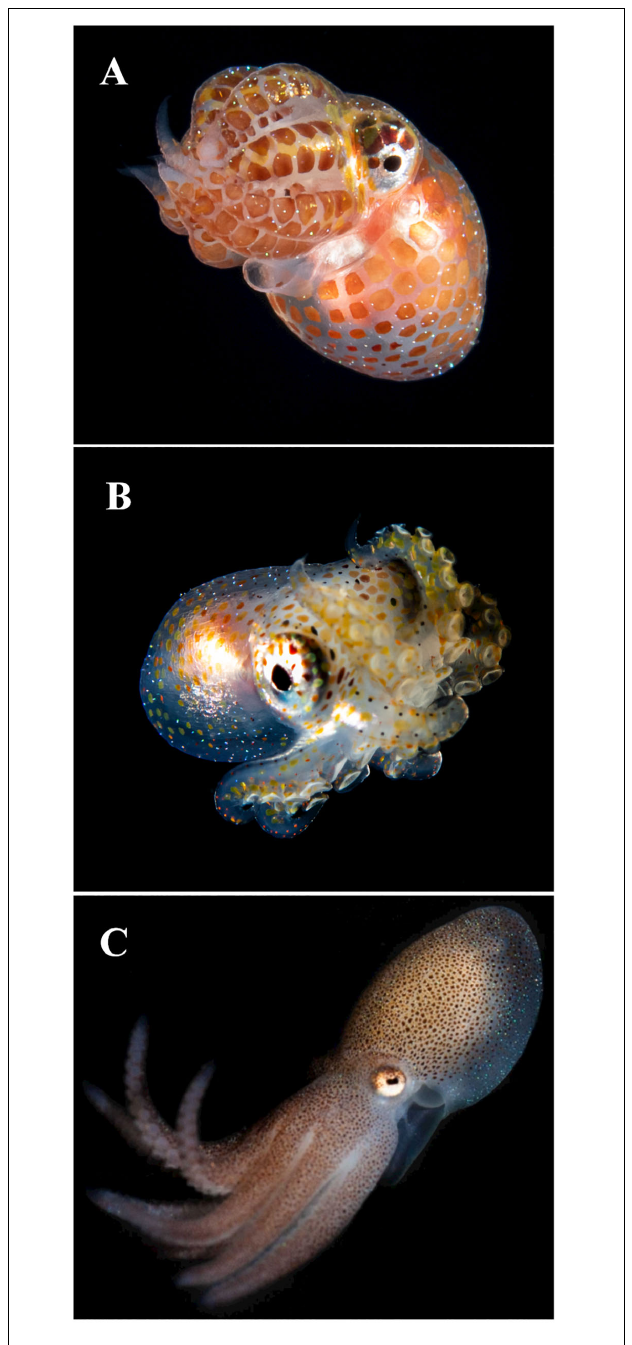
FIGURE 1 | Young octopuses showing Kölliker’s organs (KO) over the skin of mantle, head and arms in the form of tiny chitinous setae. Note the blue birefringence of the KO. (A) Unidentified Octopodidae photographed during blackwater dive, off the coast of West Palm Beach, Florida, over a bottom of 183–213 m deep, images collected at 9–18 m depth, 21:40 h, June 21, 2020. (B) Unidentified Octopodidae photographed at the same location and depth as previous individual from image (A) , at 22:20 h on July 30, 2020. (C) 2 days old juvenile of Octopus tehuelchus obtained from rearing experiments described in Braga et al. (2021). Dorsal ML 6 mm. Images (A,B) courtesy of M. Heyward Boyette, Jr., DVM; image (C) courtesy of Dr. Nicolás